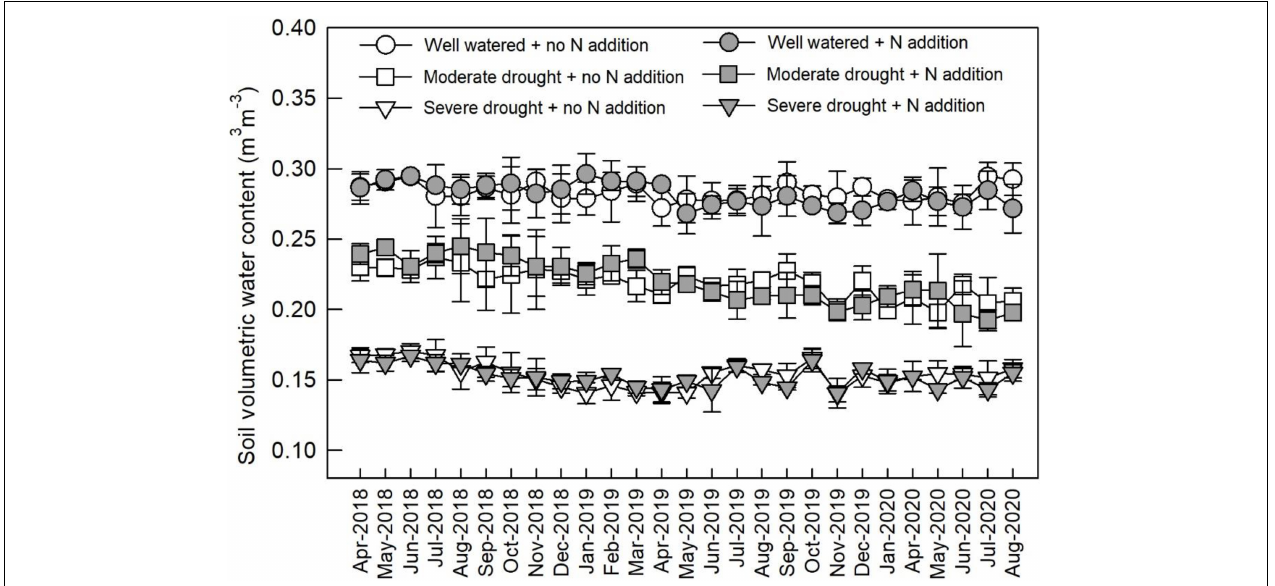
FIGURE 1 | Monthly soil volumetric water content under different watering and N addition conditions. Values are means ± SE ( n = 3).